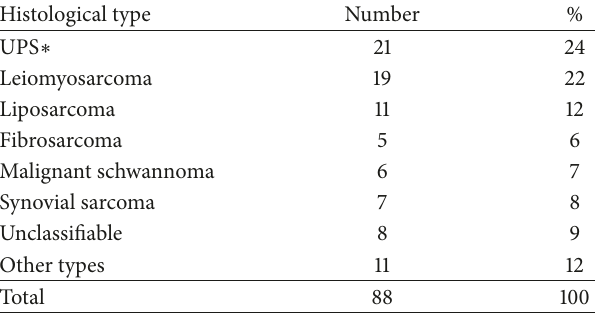
Table 3. High grade was a negative prognostic factor for OS as none of the patients with low grade tumors